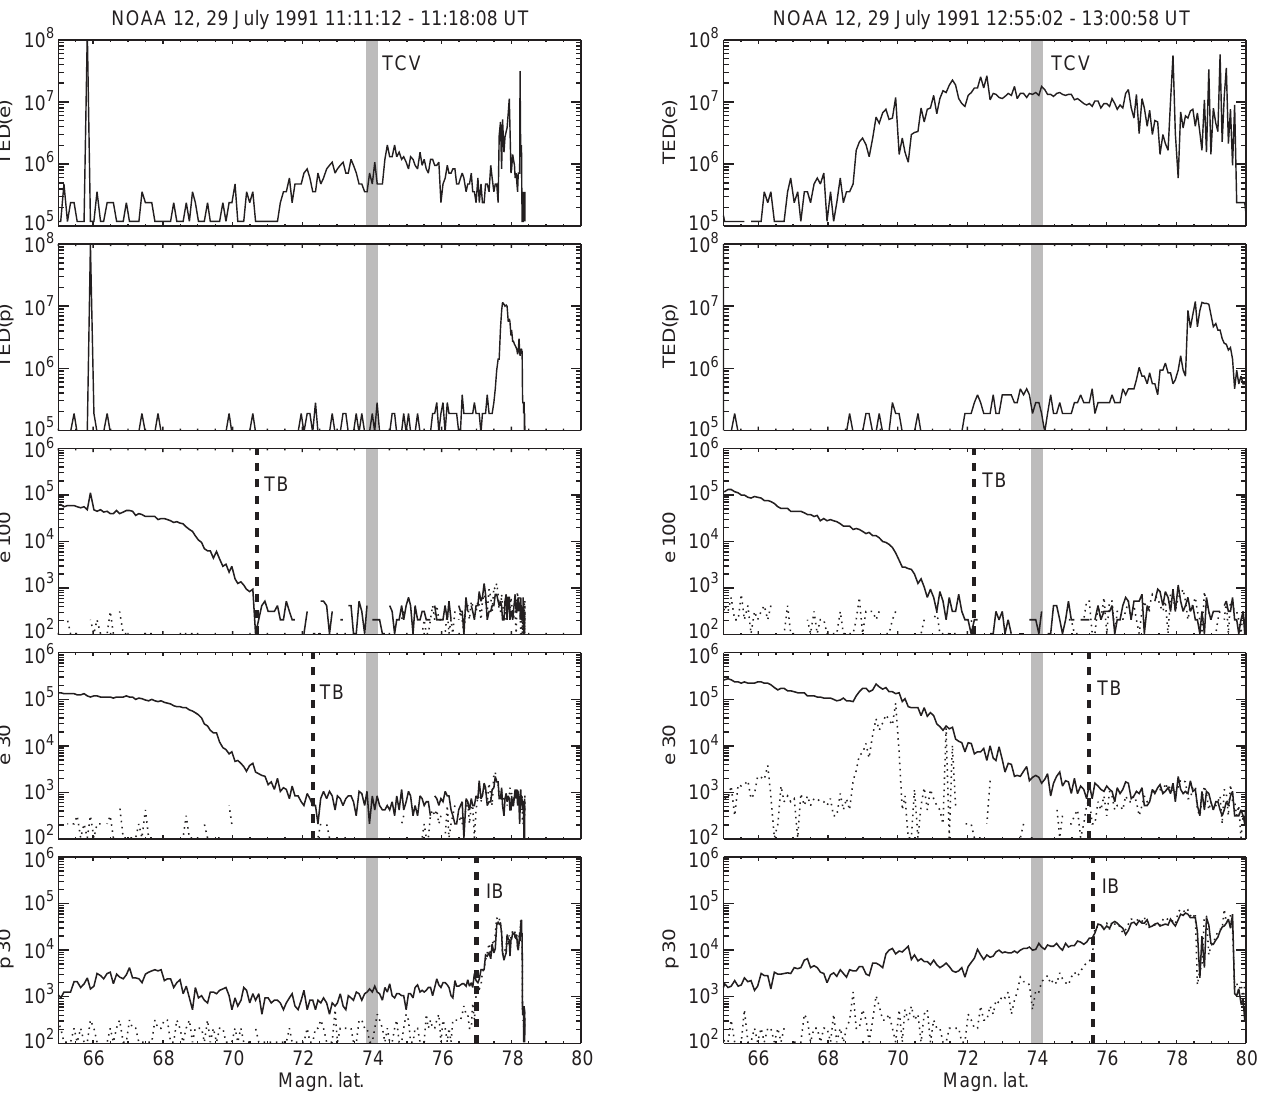
Fig. 4. TED and MEPED data from NOAA 12 for two dayside northern polar crossings on July 29, 1991. The left column is for the crossing which crosses the latitude of the TCV event at approximately 1114 UT, 10.5 MLT. The right column is for the crossing at 1257 UT,